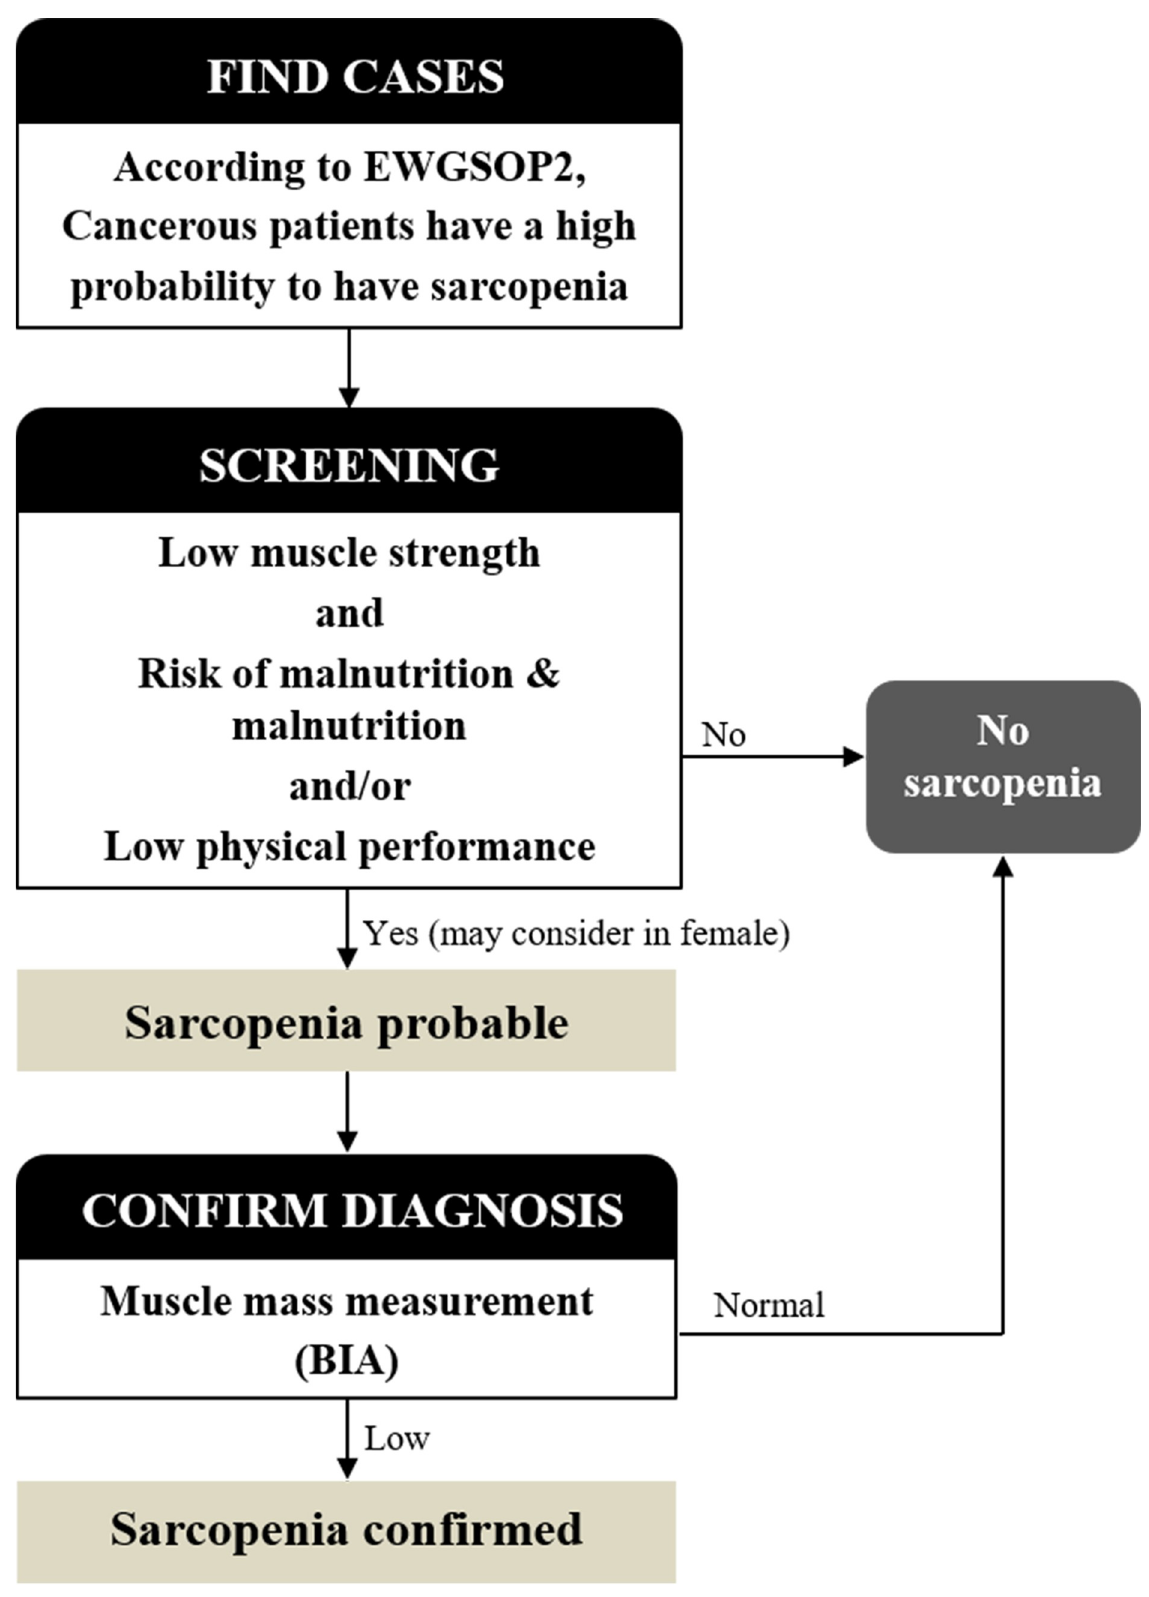
Fig 2. Algorithm for proposed sarcopenia screening in older-adult, surgical oncology patients. https://doi.org/10.1371/journal.pone.0257672.g002 PLOS ONE | https://doi.org/10.1371/journal.pone.0257672 September 23,